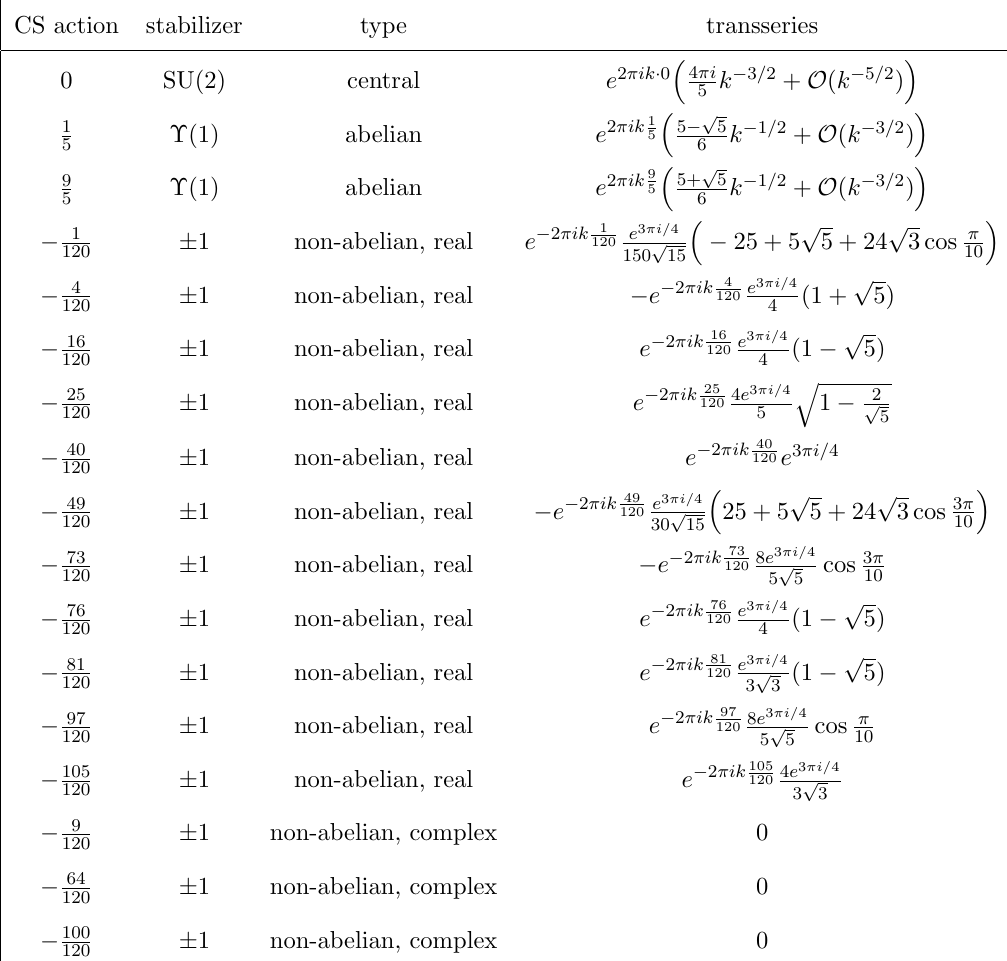
2; 1 ; 2 ; 2 ; 2 2 3 5 5 (cid:0)